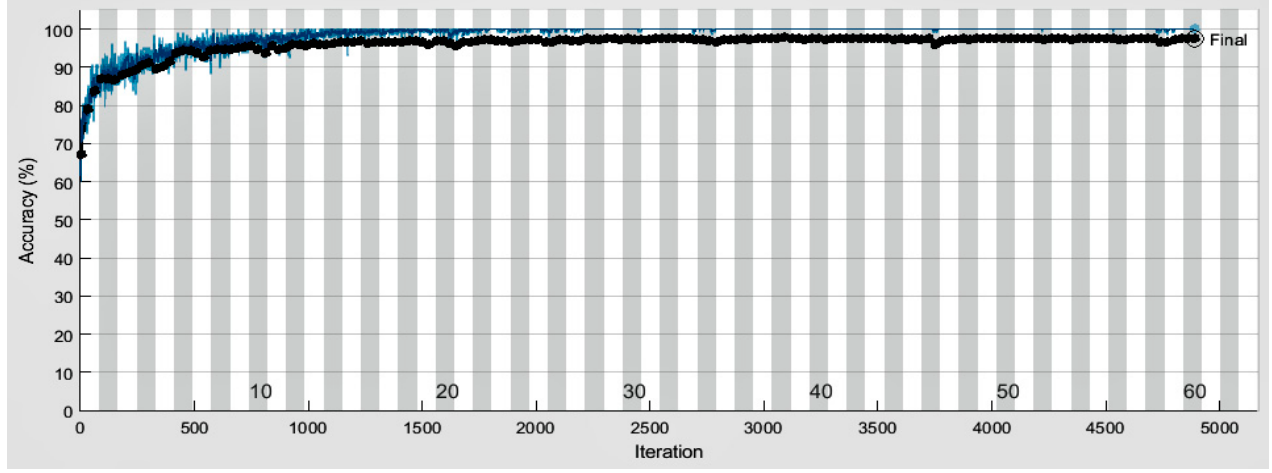
Figure 4. Training and validation accuracy of CovidDetNet model (black line shows testing accuracy whereas blue line shows training accuracy).